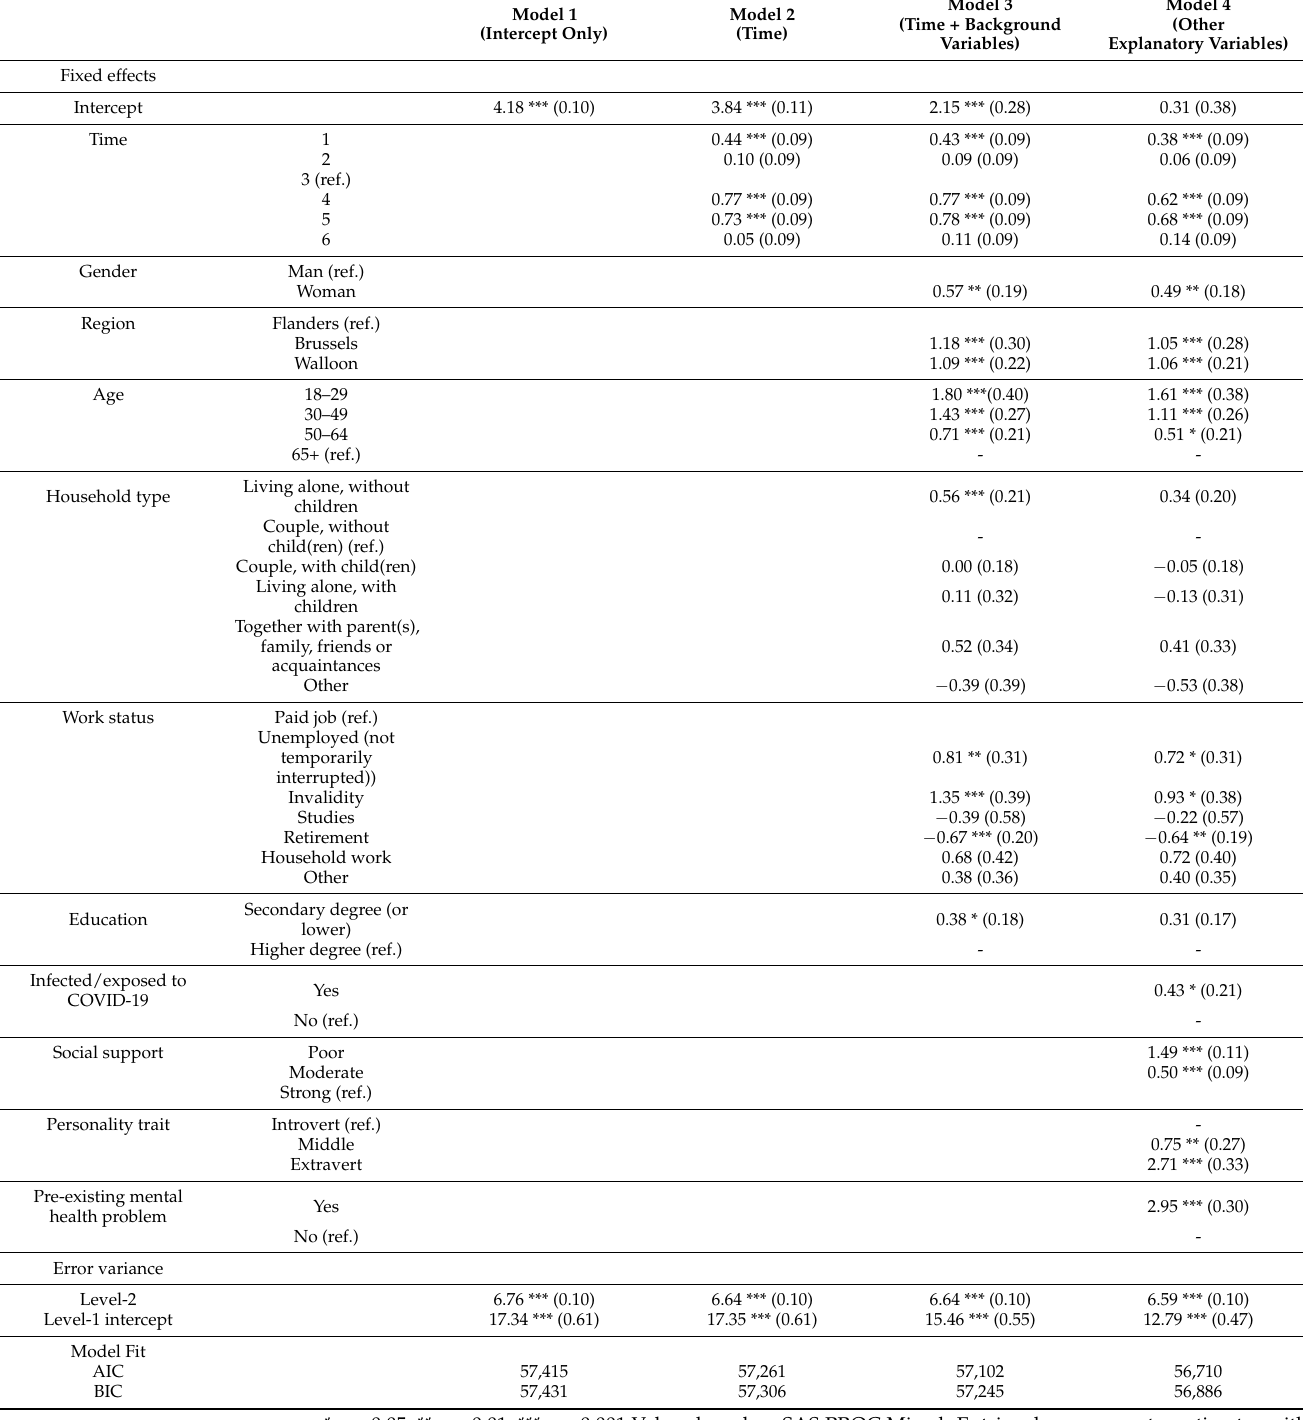
Table 4. Estimates (SE) from linear mixed models examining the total score on the PHQ-9 depression scale (N =